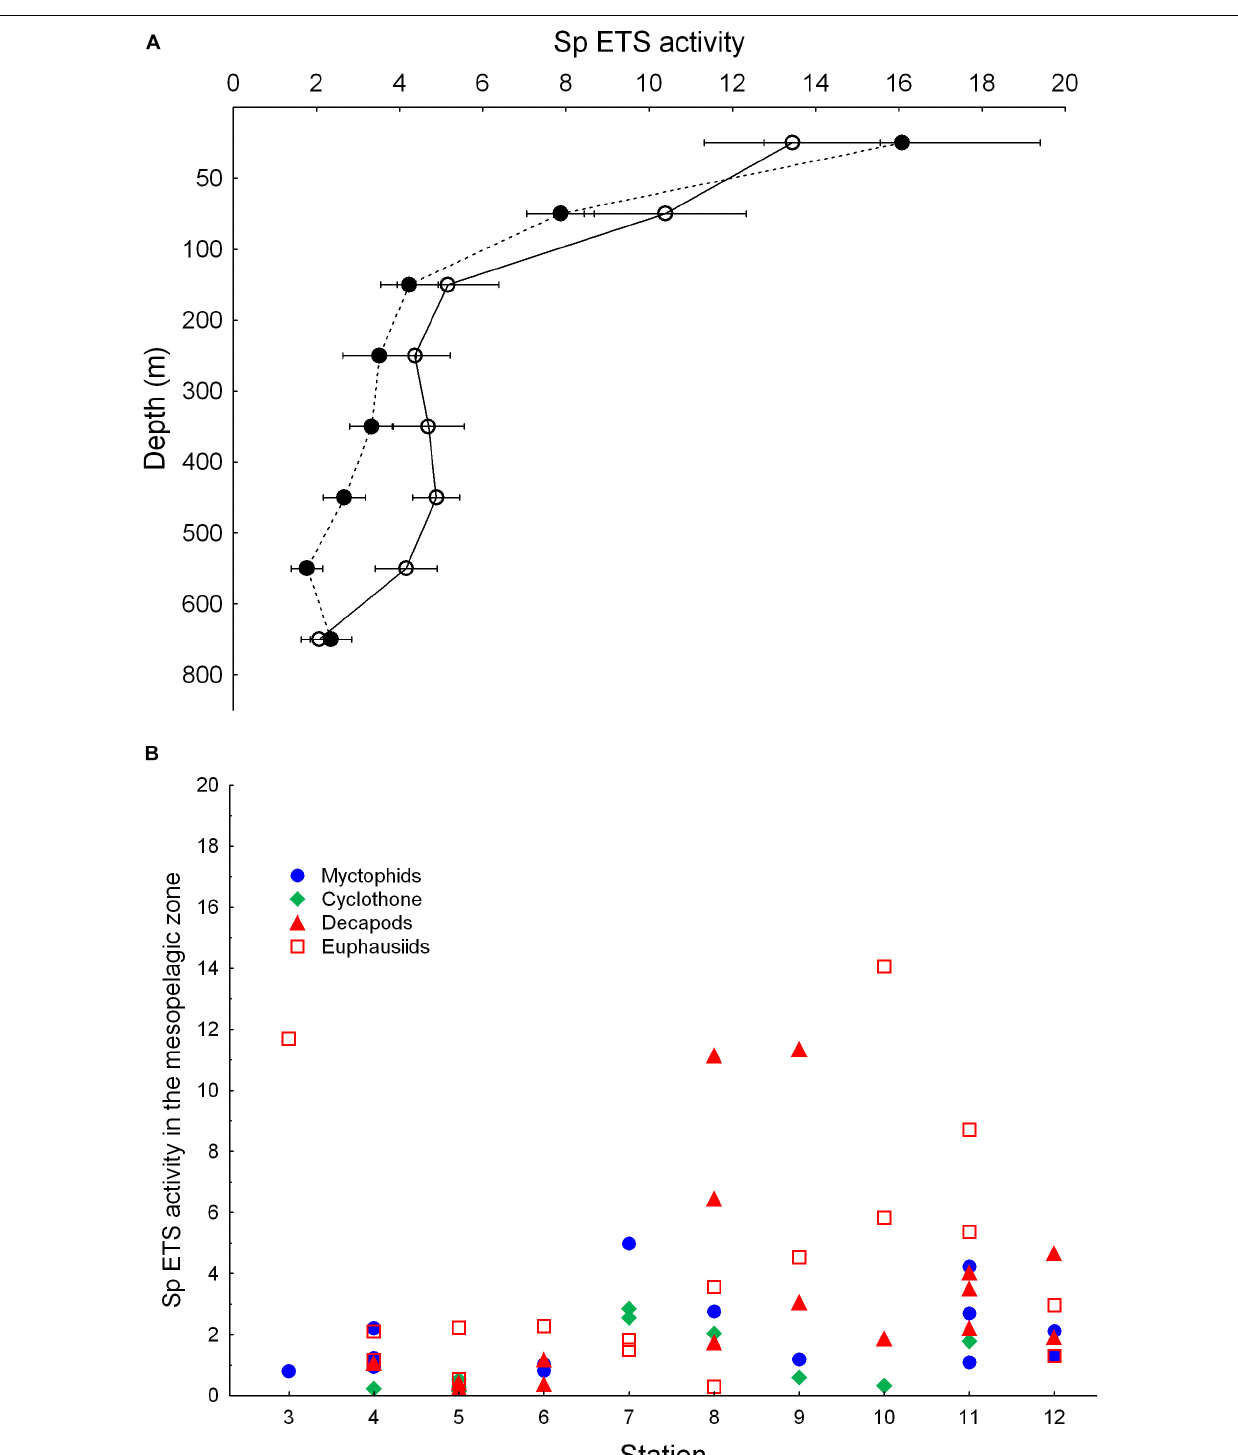
Frontiers in Marine Science |